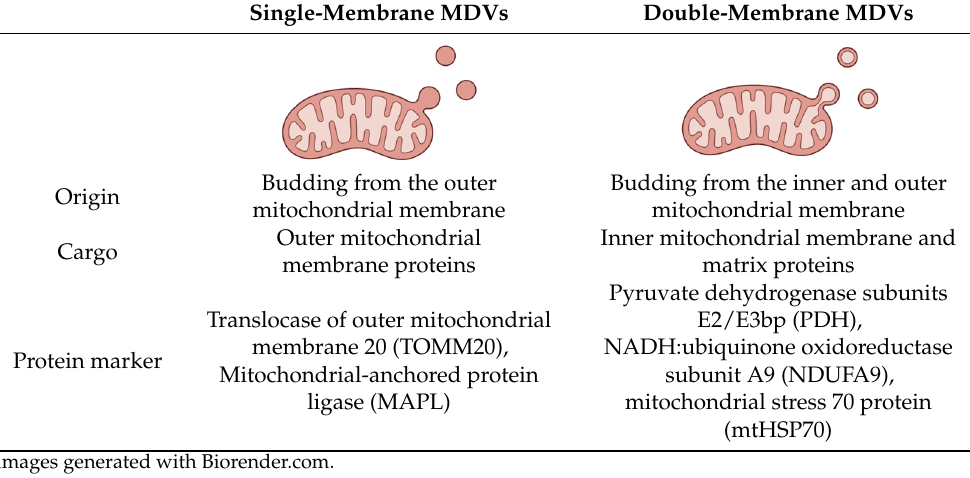
Table 1. Different types of mitochondrial-derived vesicles (MDVs).